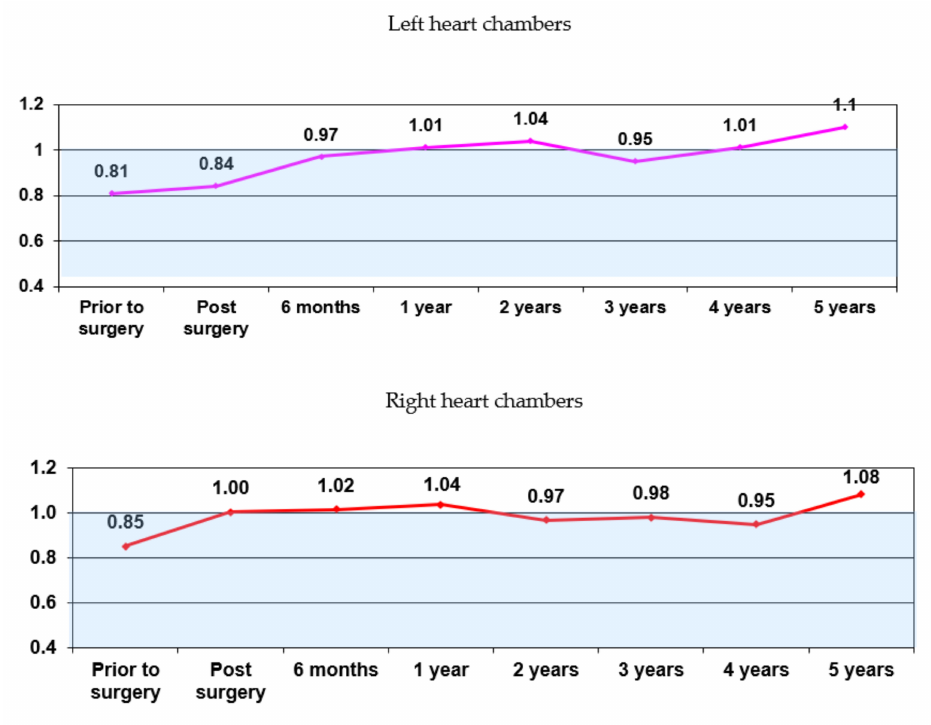
Figure 4. The IRV dynamics in all patients (n = 316).